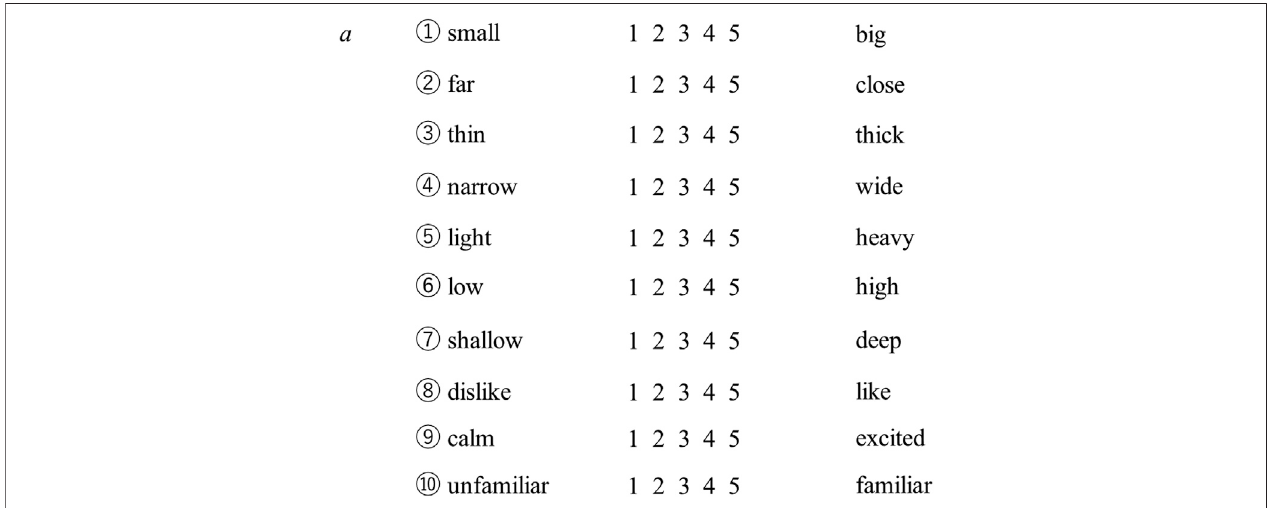
FIGURE 1 | An example of 10 semantic differential features for a Japanese katakana letter ( ア , a). In the questionnaire, all the items were shown in